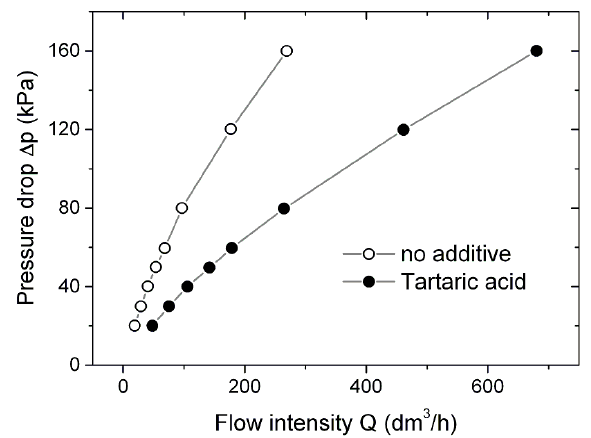
Figure 4. Relationship between pressure drop of air Δ p during penetration through the porous FeAl and flow intensity Q, with and without additive.